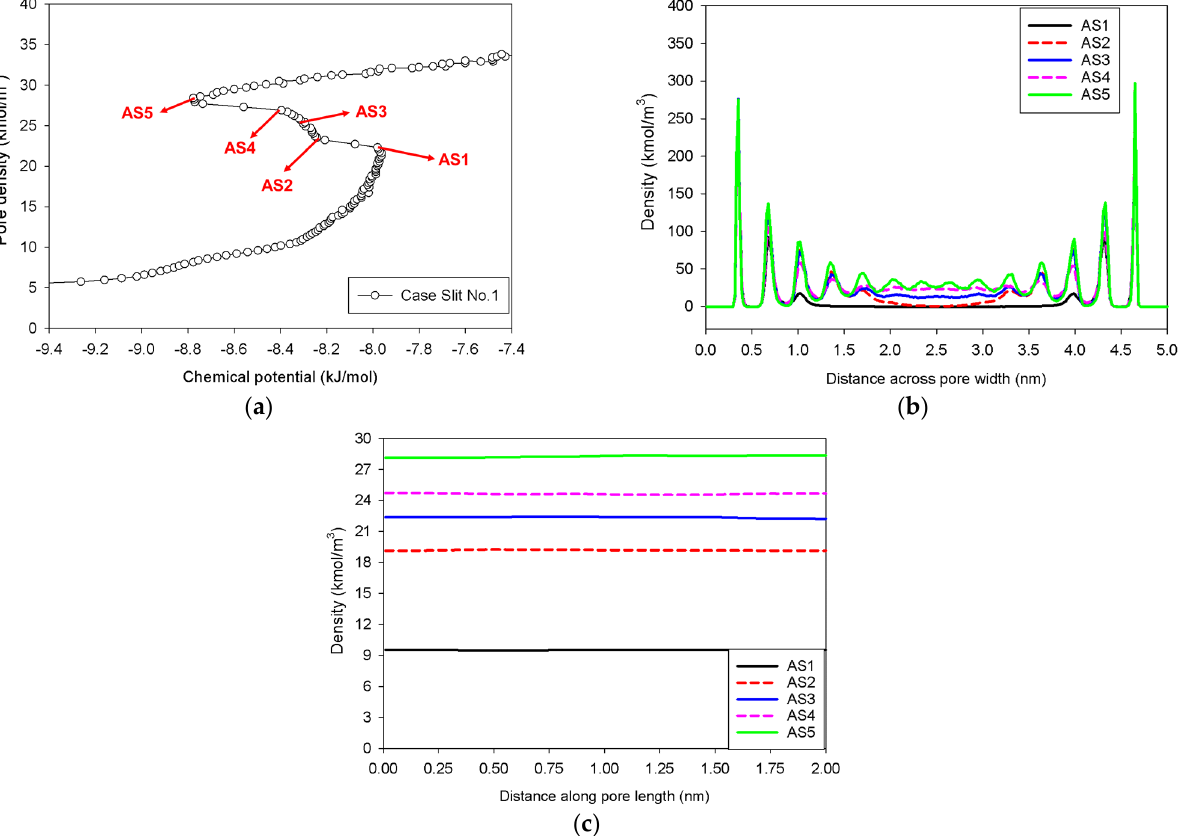
Figure 5. ( a ) Nitrogen adsorption isotherm in the infinite slit pore of 5 nm width at 77 K for Slit No.1, and its local density distributions ( b ) across pore width and ( c ) along pore length.